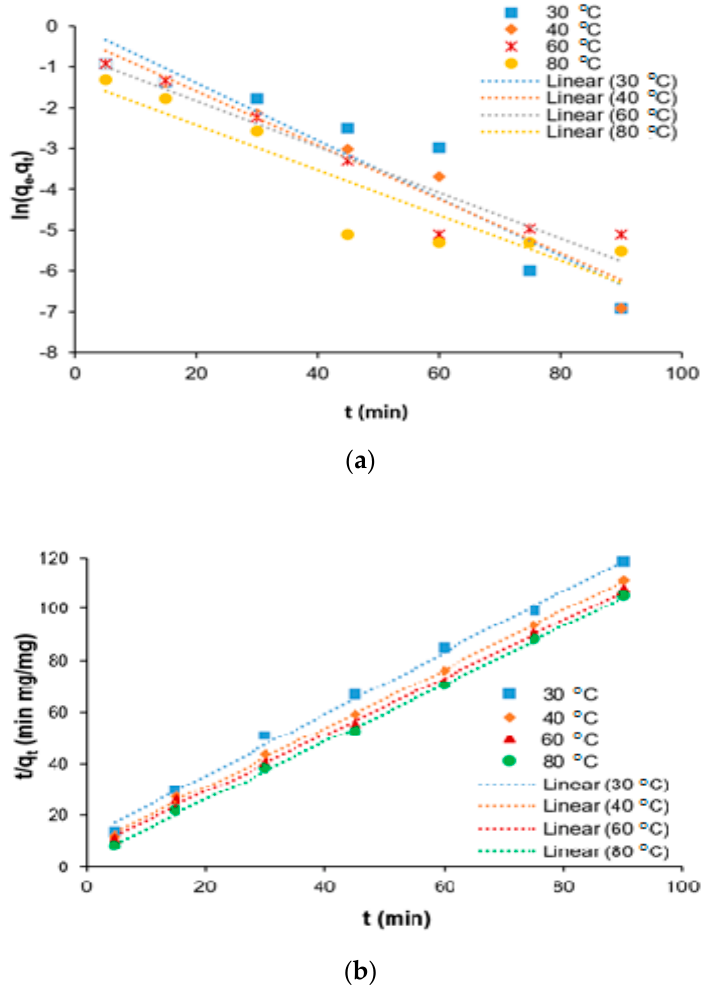
Figure 9. Adsorption kinetics studies for the removal of COD from SRPE using FeSO 4 · 7H 2 O as a coagulant. ( a ) Pseudo-first-order kinetic model and ( b ) pseudo-second-order kinetic model.